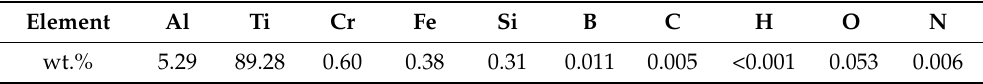
Table 1. Chemical composition of